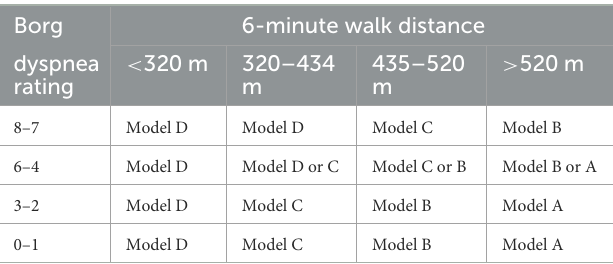
TABLE 1 Qualification criteria for pulmonary rehabilitation model.